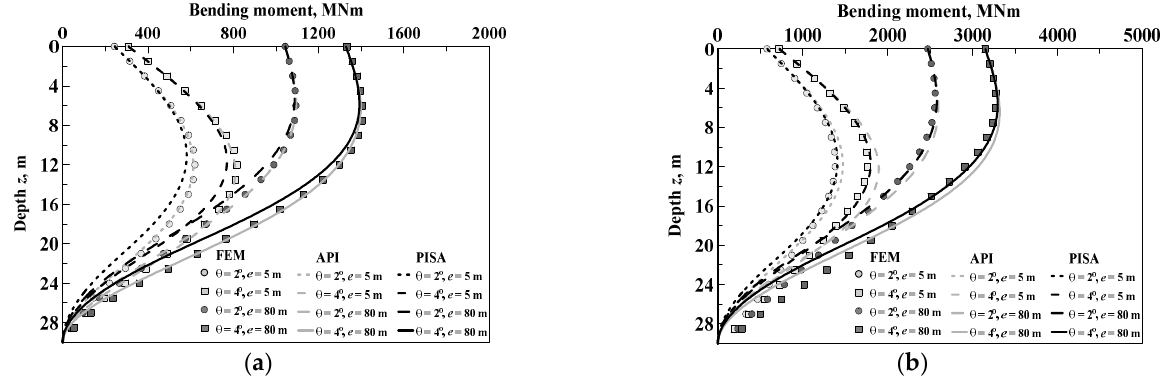
Figure 8. Bending moment profiles under typical rotations and loading eccentricity in 65% relative density sand: ( a ) D = 4 m, ( b ) D = 10 m.